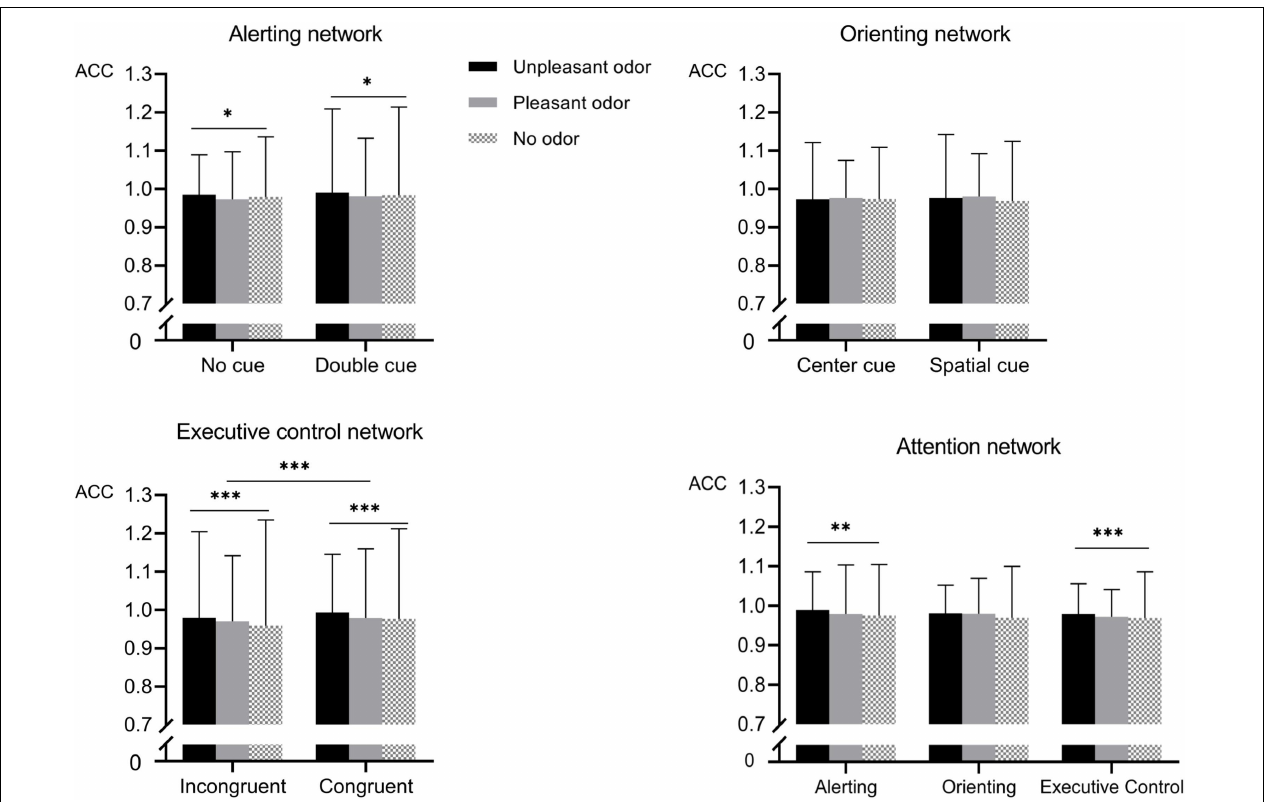
FIGURE 4 | Accuracy (ACC) for the different odor conditions for each attention networks. Values represent the mean, and error bars indicate the standard error (SE). ∗ p < 0.05; ∗∗ p < 0.01; ∗∗∗ p < 0.001.